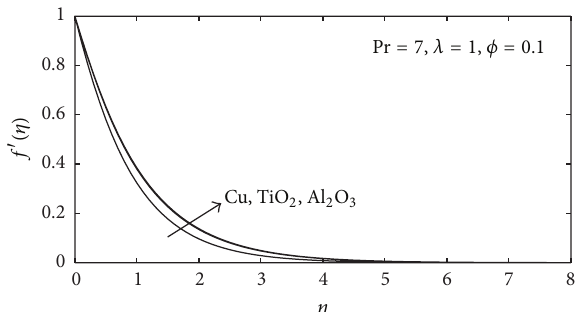
Figure 6: Velocity profiles 𝑓 󸀠 (𝜂) for different types of nanoparticles when Pr = 7 , 𝜙 = 0.1 , and 𝜆 = 1